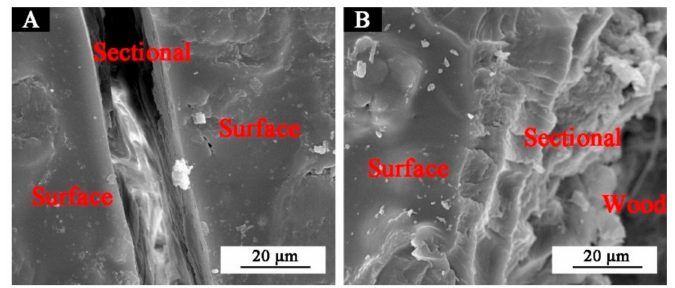
Figure 12. Cross-sectional SEM of waterborne primer coating with 10.0% concentration of microcapsules (core–wall ratio is 0.58:1). ( A ) Surface and section; ( B ) coating surface, section and wood.